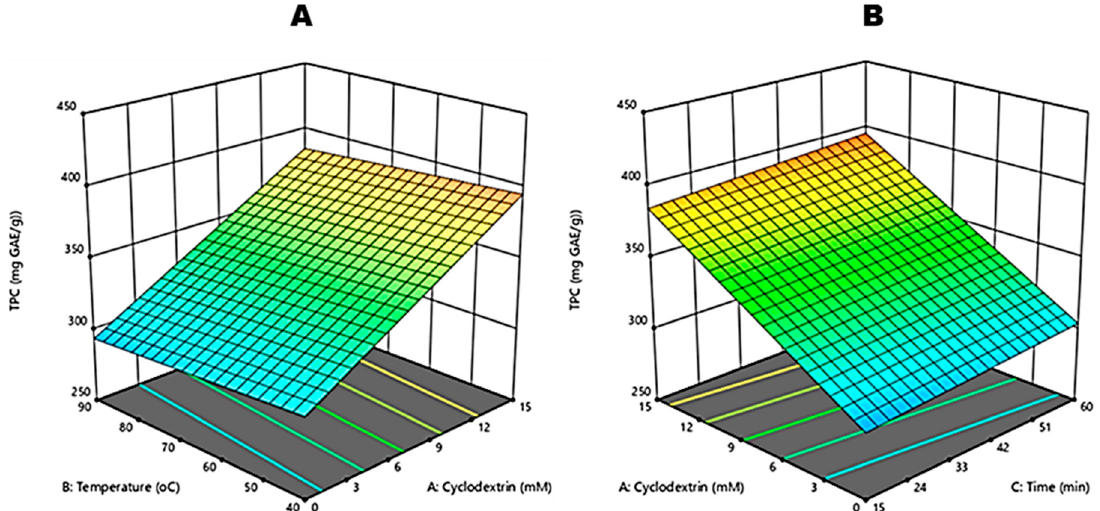
Figure 2. Response surface plots for independent variables for total polyphenolic content (TPC) of crude green rooibos extract: effect of Beta-cyclodextrin and reaction temperature ( A ) and the effect of Beta-cyclodextrin and reaction time ( B ).